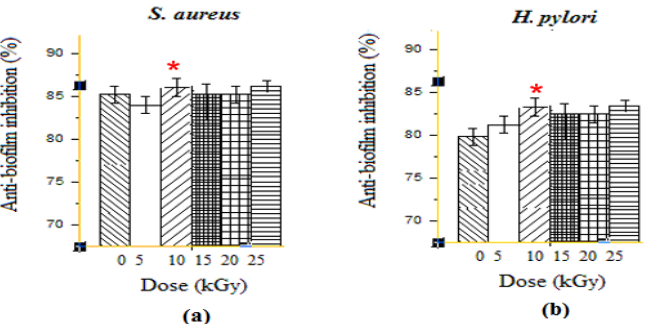
Figure 2. Determination of anti-biofilm activities effects of gelatine–chitosan–pomegranate peel (GEL–CH–PP) composite against S. aureus ( a ) and H. pylori ( b ) strains with different γ -radiation doses, 5, 10, 15, 20, and 25 kGy, in comparison with control samples (0 kGy). * Significant difference in the indicated group, as compared to that of 5 kGy group ( p < 0.05).